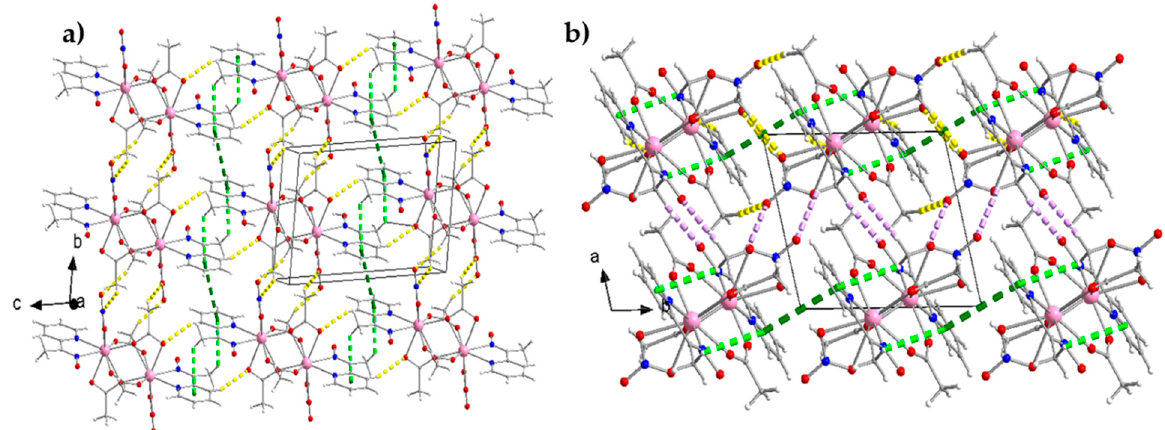
Figure 6. ( a ) 2D arrangement of the isomorphous complexes 1 and 5 parallel to the (100) plane. Thick dashed yellow lines indicate the C4-H(C4) · · · O7 (2.49 Å), C9-H B (C g ) · · · O4 (2.43 Å) and C11-H B (C11) · · · O2 (2.60 Å) H bonds, where C4 is an aromatic carbon atom of the mepaoH ligand and C9, C11 are the methyl carbon atoms of the crystallographically independent acetato groups. Thick dashed light green and dark green lines represent the C-H · · · π and π · · · π interactions, respectively, described in the text; ( b ) stacking of layers parallel to the a crystallographic axis for 1 and 5 . Thick dashed violet lines represent the C1-H A (C1) · · · O1 (2.52 Å) and C1-H B (C1) · · · O4 (2.59 Å) H bonds, where C1 is the methyl carbon atom of the mepaoH ligand. All the distance and angle parameters for the H bonds, as well as the symmetry operations are listed in Table S3.